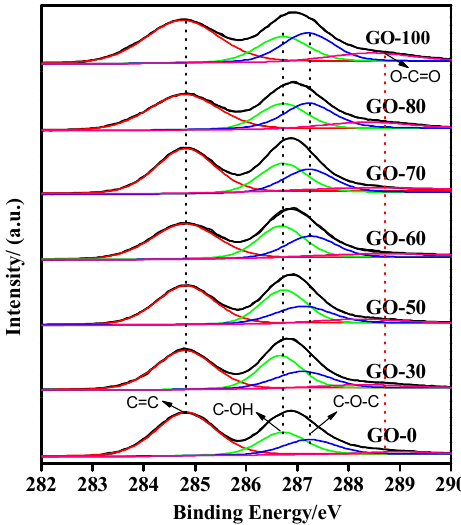
Figure 7. XPS spectra and the content of each functional group of graphite oxide prepared at different reaction temperatures. Table 1. Content of each functional group of graphite oxide prepared at different reaction temperatures.